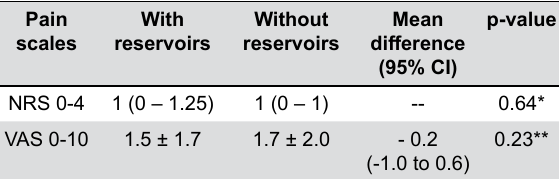
Table 4- Intensity of tooth sensitivity for both groups, mean difference of the paired VAS means and mean difference along with 95% confidence interval